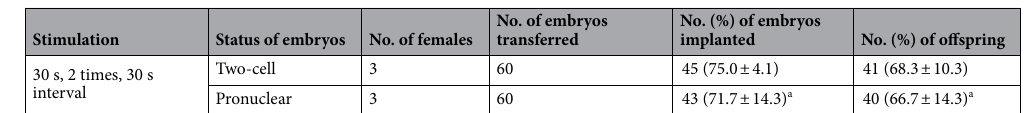
Stimulation Status of embryos No. of females